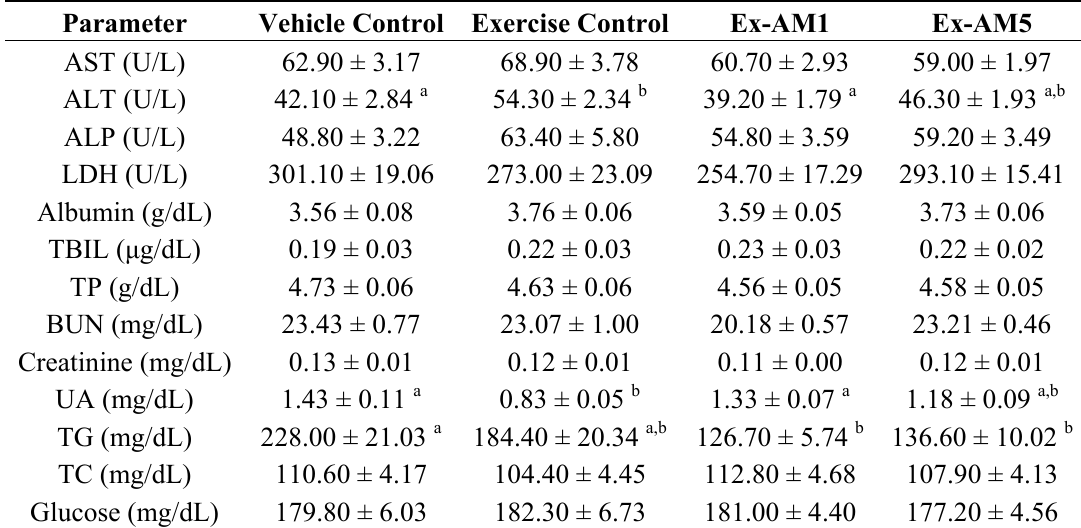
Table 2. Biochemical analysis of the AM treatment groups at the end of the experiment. Parameter Vehicle Control Exercise Control Ex-AM1 AST